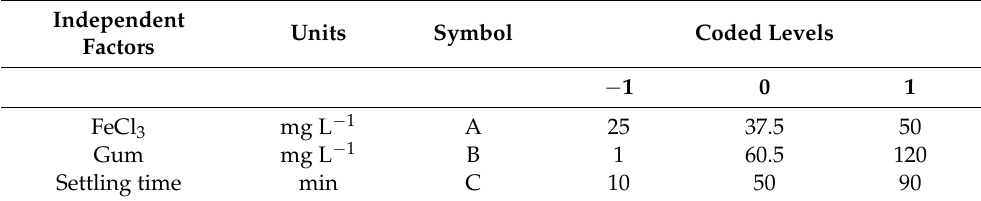
Table 1. Levels of each factor for the Box–Behnken design